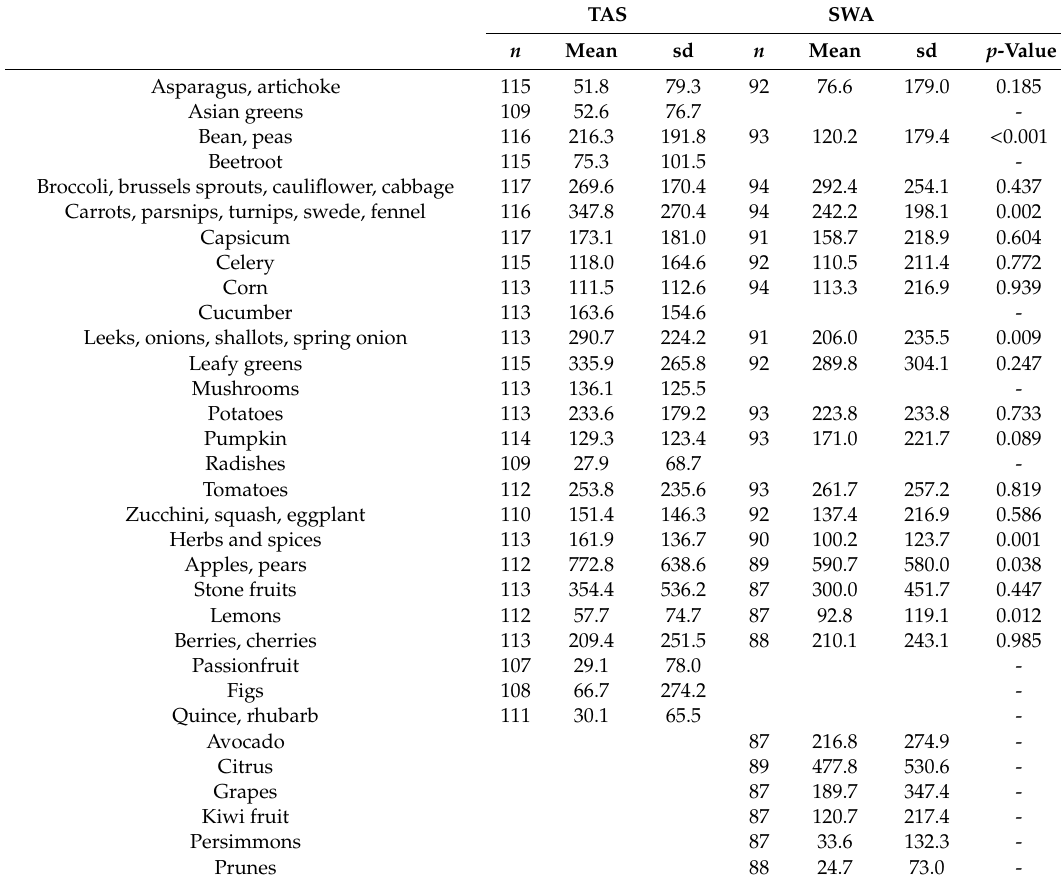
Table 3. Consumption (g per week) of selected regionally grown fruit and vegetables TAS and